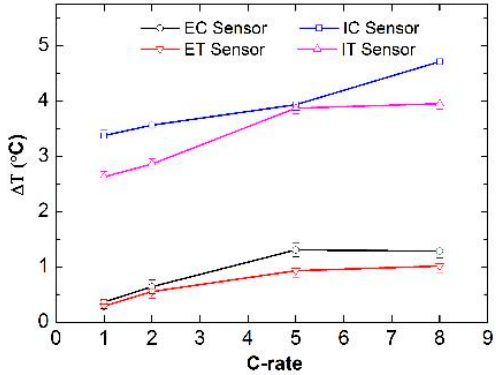
Figure 5. Correlation of the C-rate with the maximum Δ T recorded during cycling.